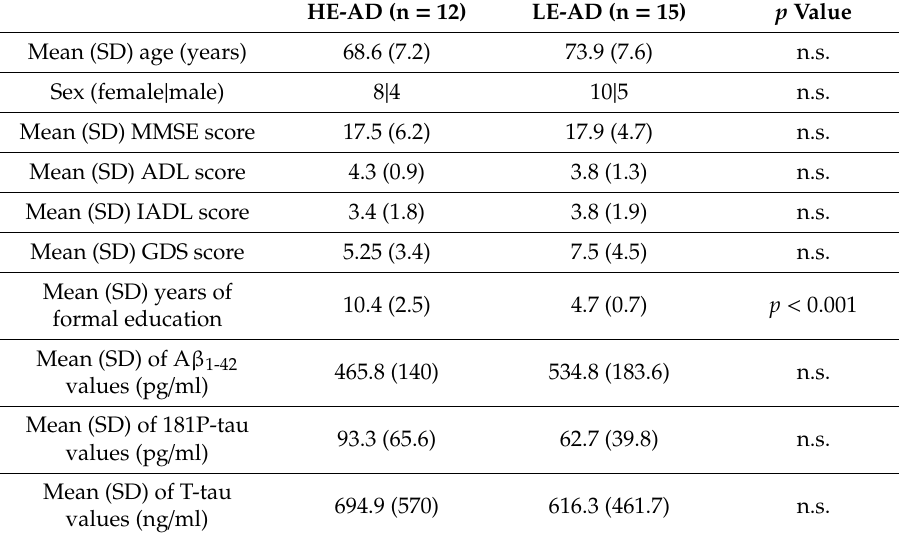
Table 2. Clinical and biochemical features of studied population level